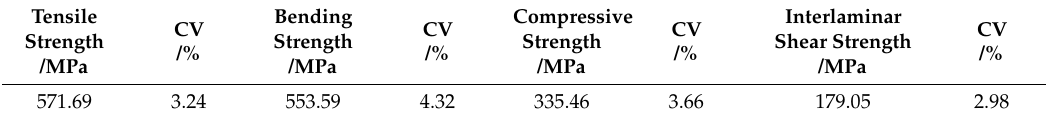
Table 5. Mechanical properties of samples under different